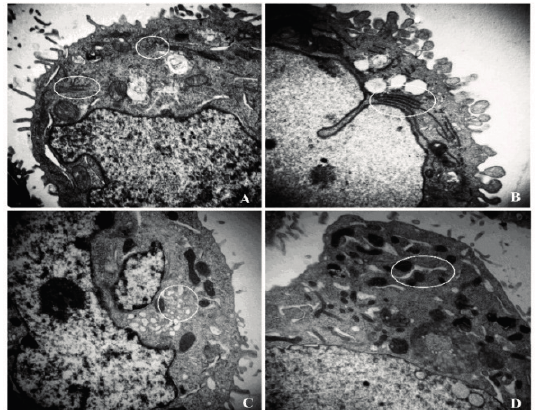
Figure 4. Structural damages of endoplasmic reticulum (ER) after treatment of X12-PG. ( A – D ) were respectively treated with 0, 400, 800, 1600 μ g/mL X12-PG for 48 h. Cells were observed by TEM (×20,000). The encircled regions show the location of ER.